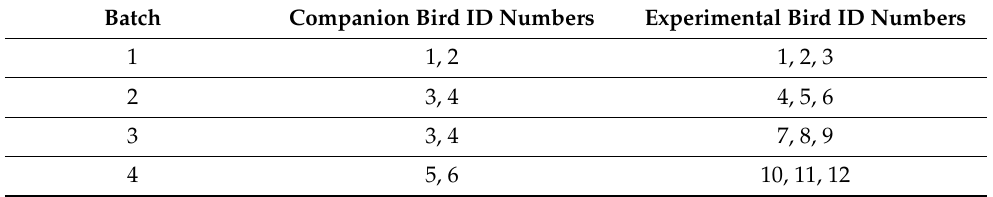
Table 1. Experimental and companion bird allocation according to their ID numbers and batch.